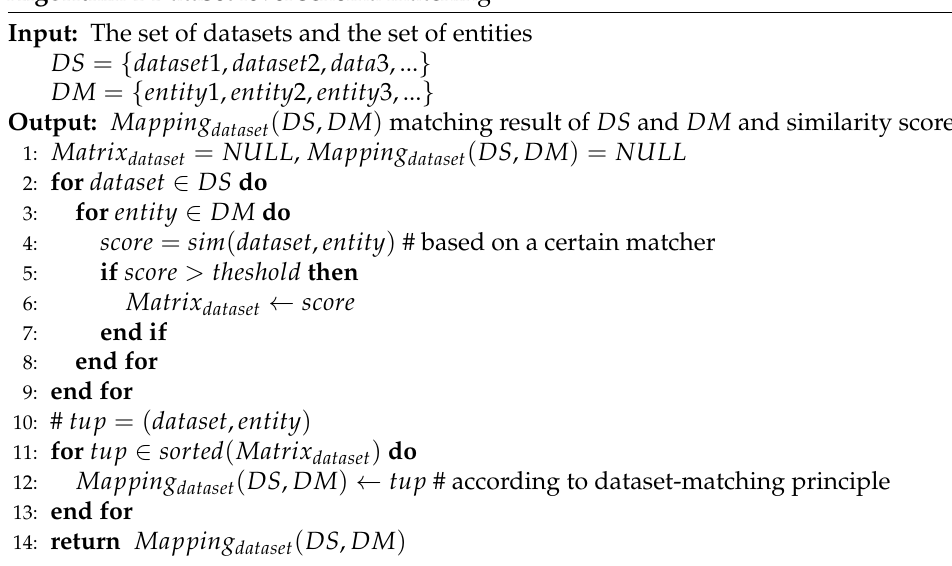
Algorithm 1 Dataset level schema matching